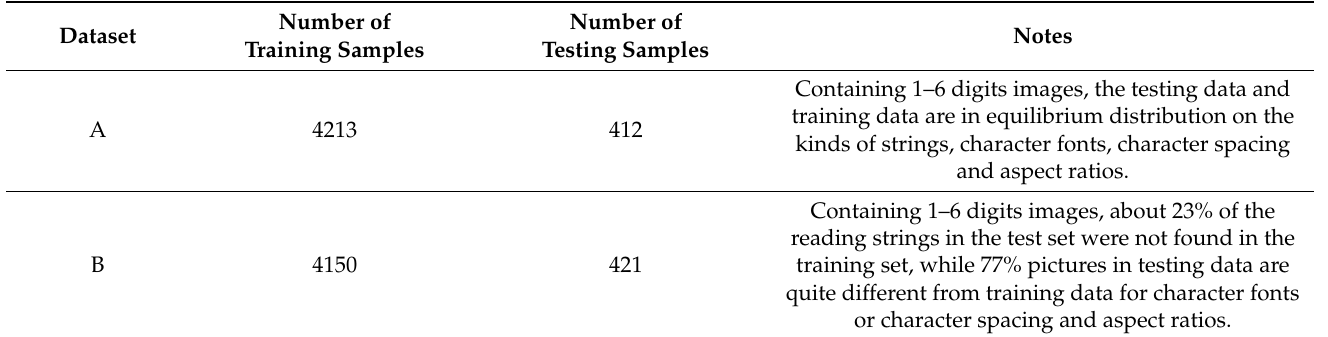
Figure 7. Some raw images and some samples in the basic dataset. Table 1. The datasets distribution used in our